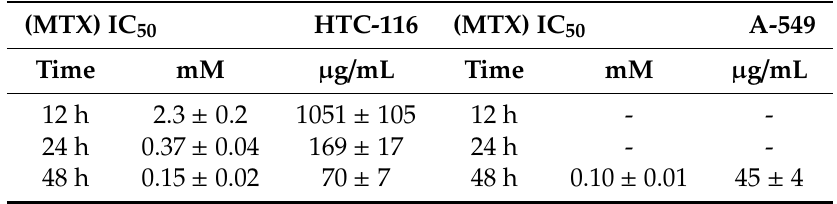
Table 2. IC 50 values of free MTX at 12, 24 and 48 h for cell lines HTC-116 and